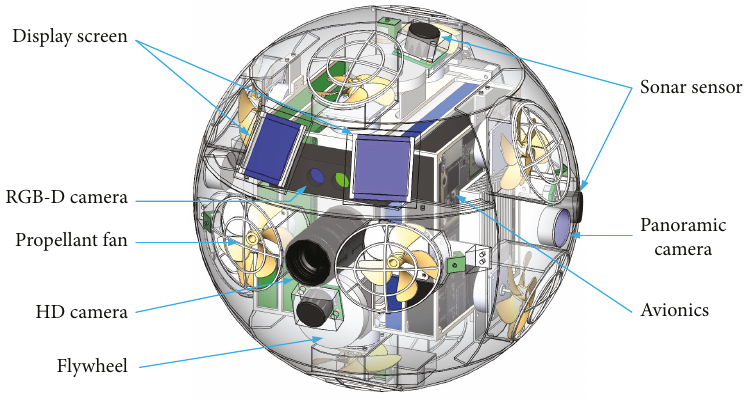
Figure 1: Prototype of the Intelligent Formation Personal